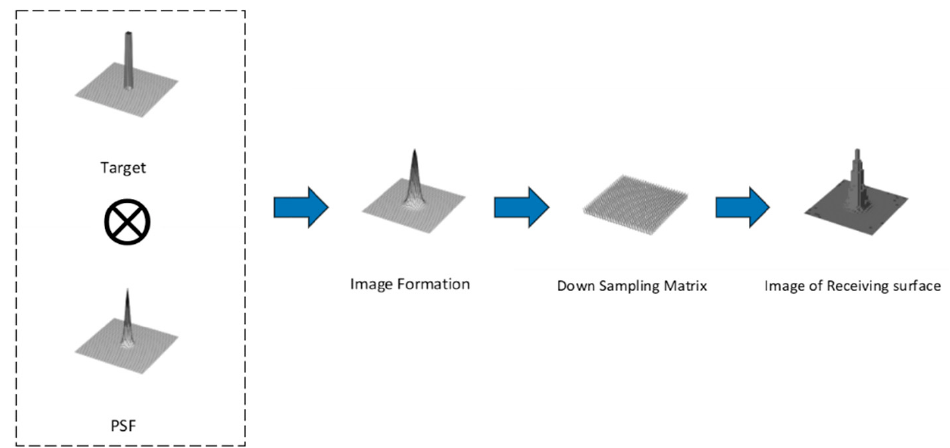
Figure 2. Schematic of the imaging process: point target and point diffusion function convolution after array down-sampling to form the fi nal imaging results.